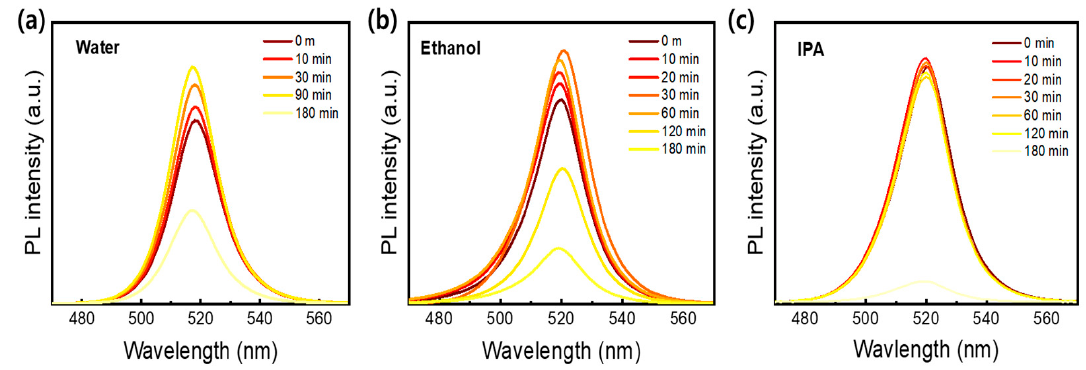
Figure 3. ( a – c ) PL spectra of CsPbBr 3 /SiO 2 NCs solution in ( a ) water, ( b ) ethanol, and ( c ) IPA as time increased.